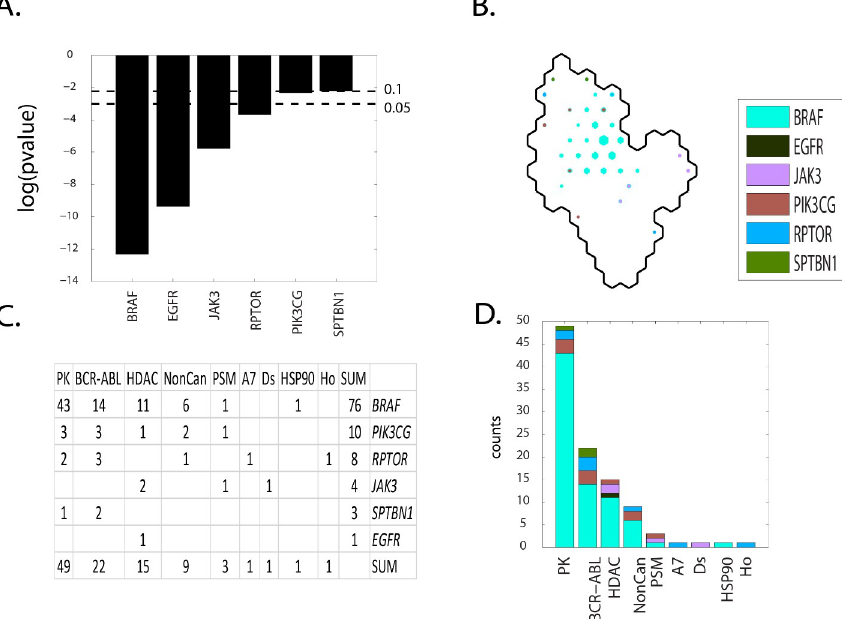
Fig 13. Results for group E(meta-clades 19 through 20). The SOM DTP region displayed in Panel B represents the boundary for meta-clades 19 through 20 (see the white border in Fig 8 Panel A ). S10 master_appendix sheet gp_E lists the table in Panel C. See legend to Fig 9 for additional details. S17 master_appendix sheet gp_E_FDA lists the FDA compounds associated with these defective